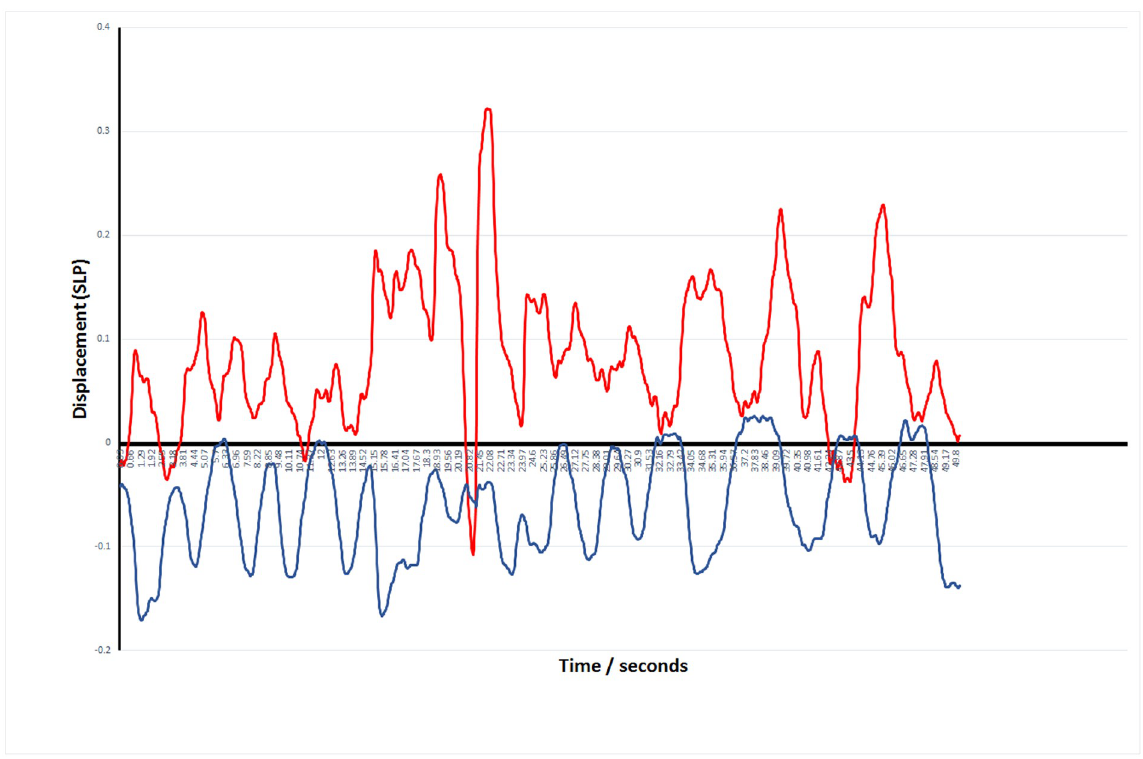
Fig 14. Rib cage and abdominal displacement measured with SLP during 10 breaths for a patient with spinal muscular atrophy (Type 2) showing clear evidence of paradoxical breathing.